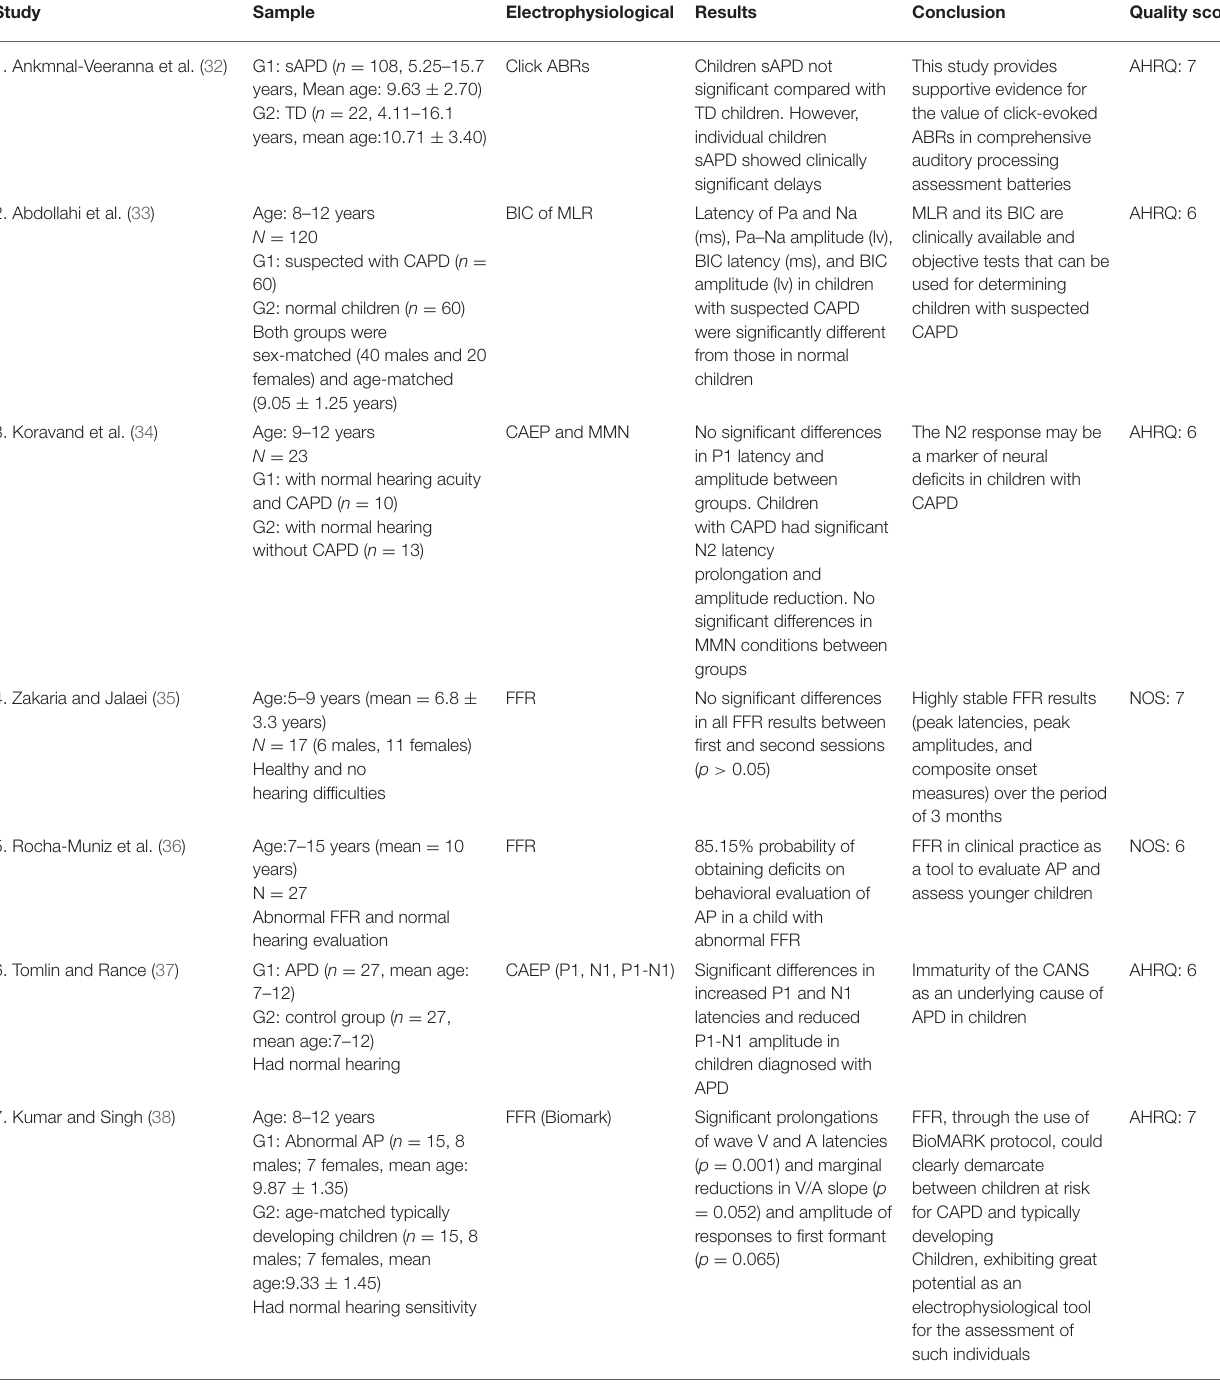
TABLE 1 | Data of selected articles, including study, sample, electrophysiological, results, conclusion and quality score.